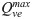
Effect of the venous return augmentation.Cardiac output curves of FP#4 at rest (black) and during dobutamine stress with the cardiac output-venous return equilibrium points of the closed-loop system marked by asterisks—purple for the cardiac output at stress while the venous return kept as at rest, and blue allowing an increase of venous return (Qvemax increased by 45%) during dobutamine stress.